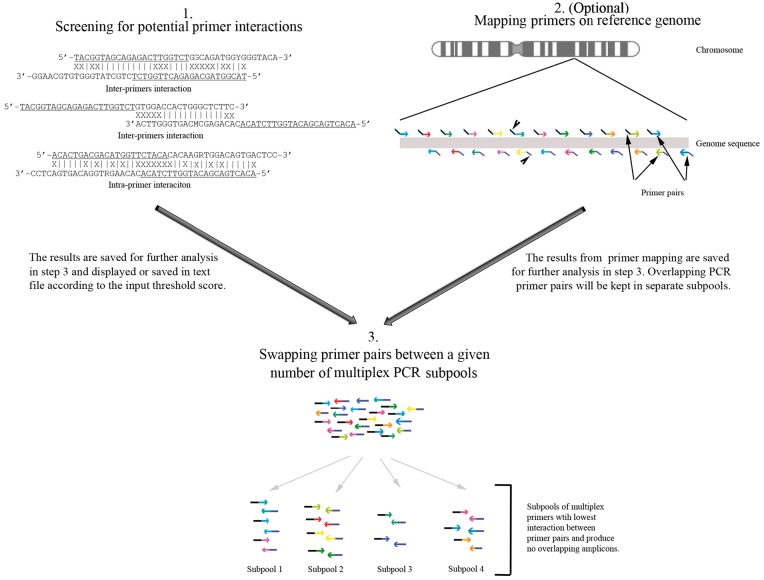
 Schematic showing the three parts of PrimerPooler. This includes (1) inter-/intra-primers hybridization analysis, (2) genome mapping and (3) the automated swapping system. For (1), the common sequences for both forward and reverse primers used as indexing/barcoding are underlined. For (2) and (3), the index sequences for primers are represented by black and blue lines attached to the 5′ ends of forward and reverse primers, respectively. The arrow heads in (2) point to the common sequences. Primer pairs are represented by the same colour. The length of each primer is not necessarily shown in proportion in the diagram.